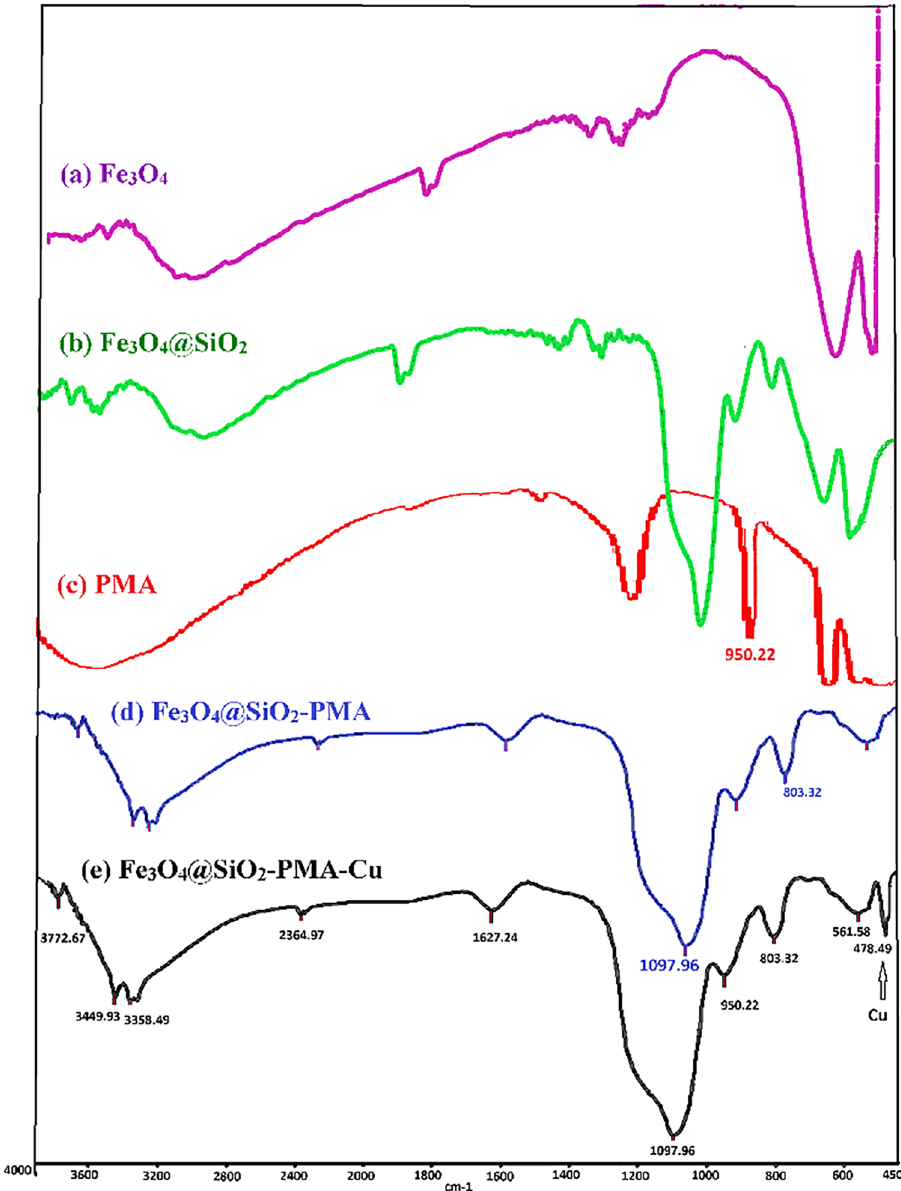
Figure 4. FT-IR (KBr) spectra of ( a ) Fe 3 O 4 , ( b ) Fe 3 O 4 @SiO 2 , ( c ) PMA, ( d ) Fe 3 O 4 @SiO 2 -PMA and ( e ) Fe 3 O 4 @